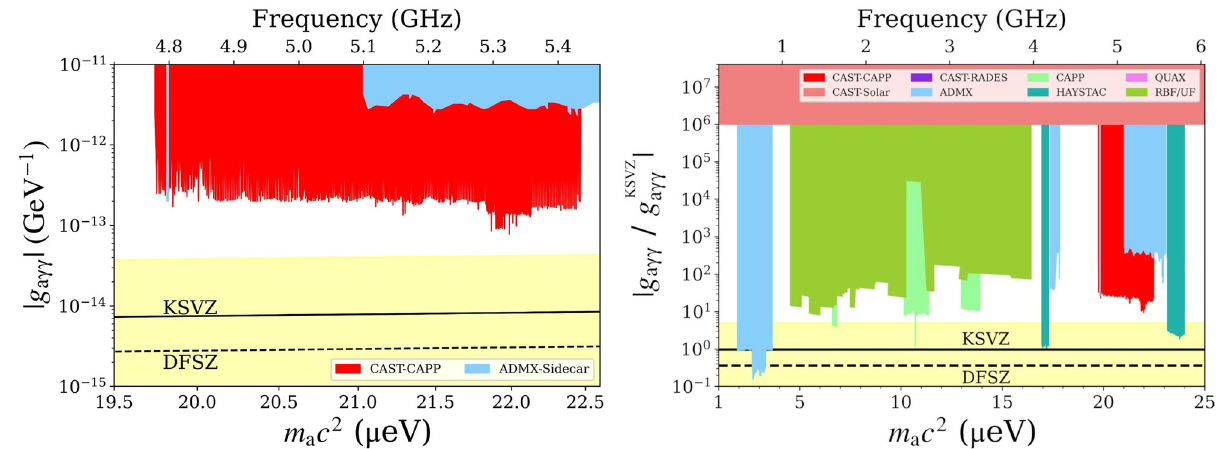
Fig. 5 | CAST-CAPP exclusion limit on the axion-photon coupling as a function of axion mass at 90% con fi dence level (left), and compared to other axion search results 10,25,30,34 – 41 within the mass range 1 – 25 μ eV (right). The